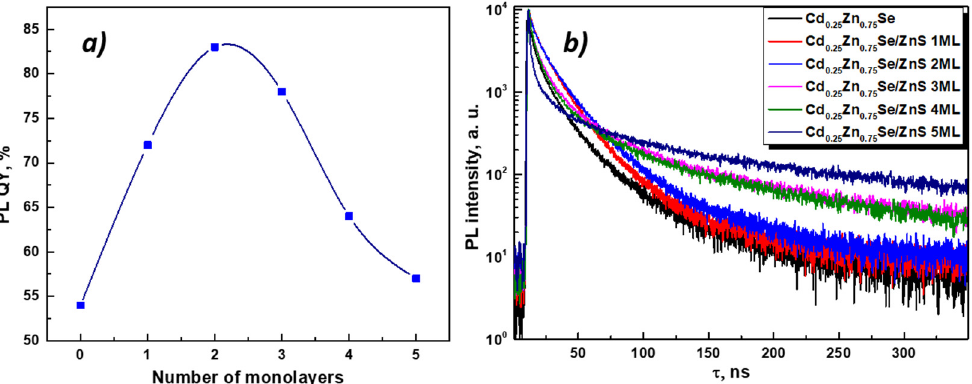
Figure 9. PL QY dependence on the shell thickness ( a ) and PL decay kinetic curves ( b ) of core/shell Cd 0.25 Zn 0.75 Se/ZnS QDs.